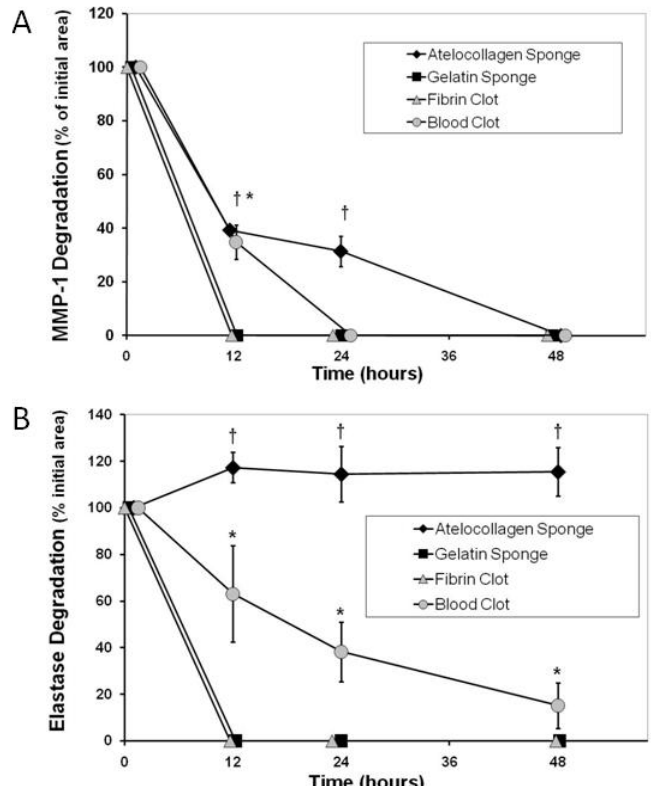
Figure 1. Enzymatic degradation of atelocollagen, gelatin, fibrin, and blood clot scaffolds over a 48 h period by ( A ) MMP-1; ( B ) Elastase and ( C ) Phosphate buffered saline (PBS) (control). By 24 h in the MMP-1 solution, the only remaining scaffolds with any integrity were the atelocollagen scaffolds and by 48 h, even the atelocollagen scaffolds had been degraded. † denotes significantly less degradation of the atelocollagen scaffolds at 12, and 24 h (p < 0.02). * denotes significantly less degradation of the blood clot scaffold than the fibrin or gelatin at the time points identified (p < 0.001 for all